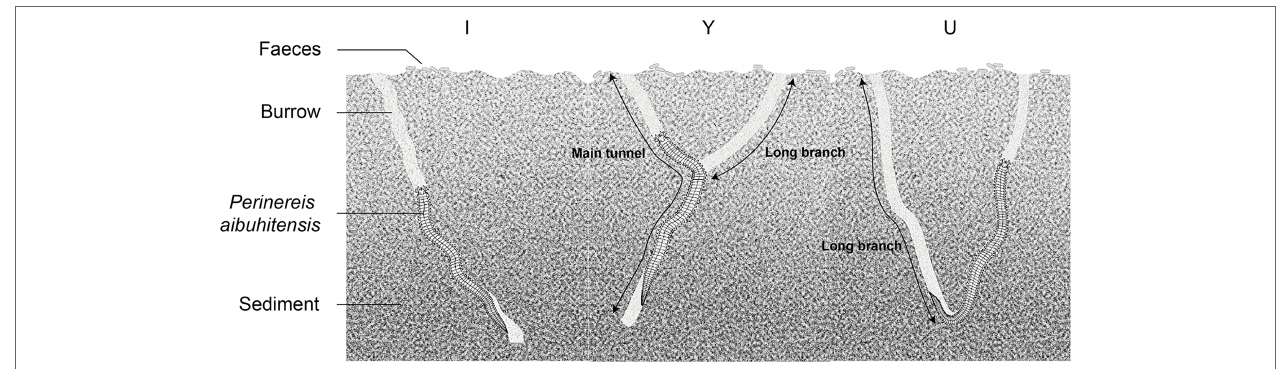
FIGURE 2 | The three burrow shapes of P. aibuhitensis observed in this